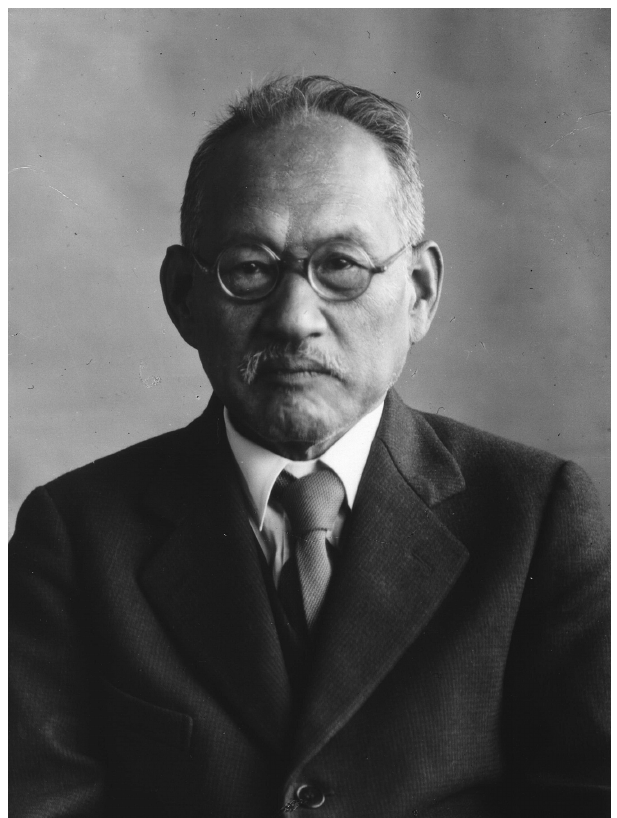
Figure 6. Takematsu Okada, head of the Central Meteorological Observatory from 1923 to 1941 (photo supplied by the Japan Mete- orological